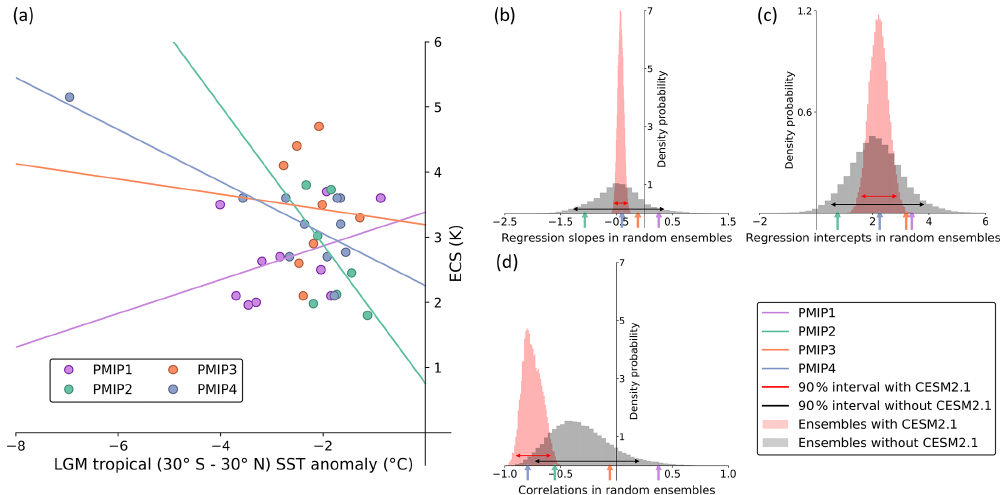
Figure 12. (a) LGM tropical SST anomaly and ECS of all models since PMIP1 and distribution of regression (b) slopes, (c) intercepts and (d) correlations from randomly sampled sub-ensemble of models. The red distribution shows ensembles where CESM2.1 was sampled, while the black distribution shows ensembles where CESM2.1 was not sampled. The colored arrows pointing at the x axis show the true values of each PMIP ensembles. Note that PMIP1 models are not available for sampling in this analysis but are only shown for comparison with other PMIPs.